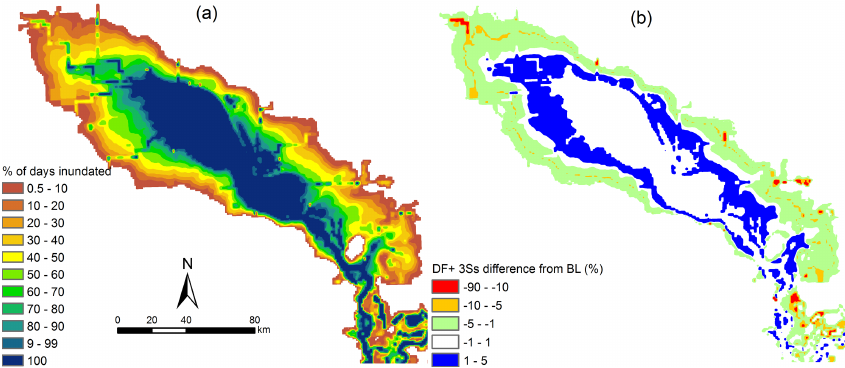
Figure 7. Maps representing the duration of flooding during the 15-year simulations: (a) shows the baseline (BL) flood duration map as percentage of total simulation time, while (b) shows the difference in flood duration between the combined definite future and 3S hydropower scenarios (DF + 3S) and the baseline. Areas with an expected increase in flood duration are shown in blue, those where a decrease in flood duration is expected in the marginally inundated areas are shown in red, green and